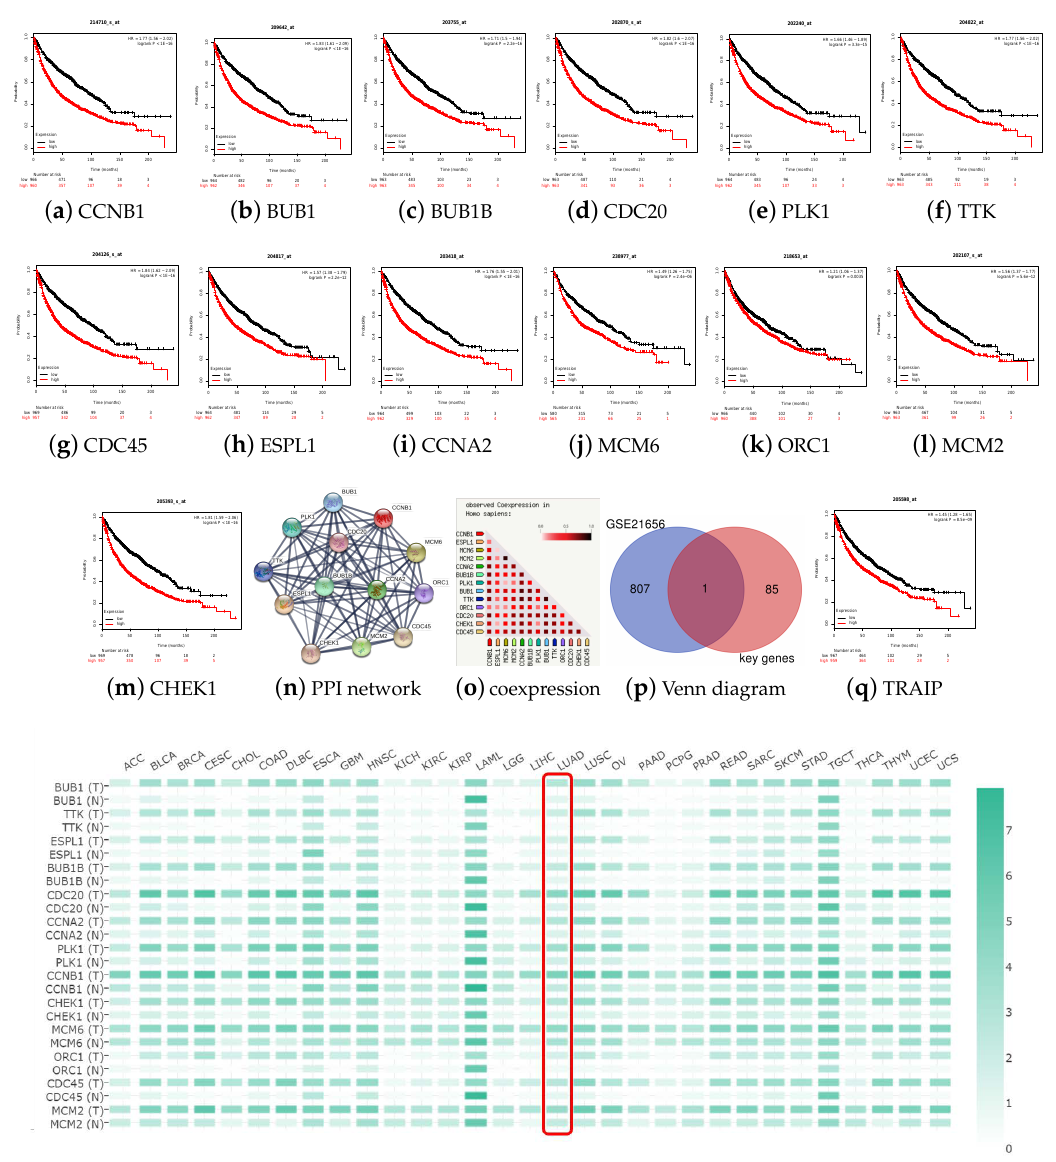
Figure 8. Validation of the key genes. Kaplan–Meier survival plots (K–M plot) were generated using the online tool, Kaplan–Meier plotter. The log-rank test was used, and a p -value < 0.001 was considered as a significant difference. ( a – m ) There are 13 cell cycle pathway genes enriched from the blue module. K–M plots were drawn to profile a gene’s prognostic value in LUAD, by the comparison of survival probability between the set of high-expression (Red curve) and the low (Black curve). The results show that the 13 key genes are related to poor outcome in LUADs; ( n ) the PPI network of 13 cell cycle genes performed by STRING, enrichment p -value < 1.0 × 10 − 16 . ( o ) Co-expression predicts a functional association. The co-expression scores are based on RNA expression patterns and protein co-regulation, provided by ProteomeHD. In the triangle-matrices above, the intensity of color indicates the level of confidence that the two proteins are functionally associated, given the overall expression data in the organism. ( p ) A Venn diagram was drawn for mapping stemness microarray GSE21656 and 86 key genes from the blue module. The intersection set within only one gene was tumor necrosis factor receptor associated factor-interacting protein (TRAIP). ( q ) The K–M plot of TRAIP is related to the